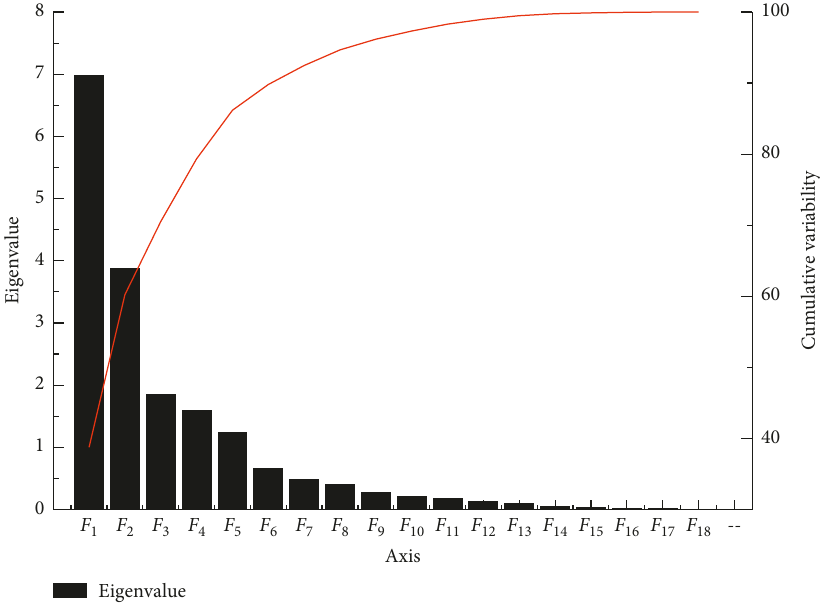
Figure 2: Scree plot of the eigenvalues of